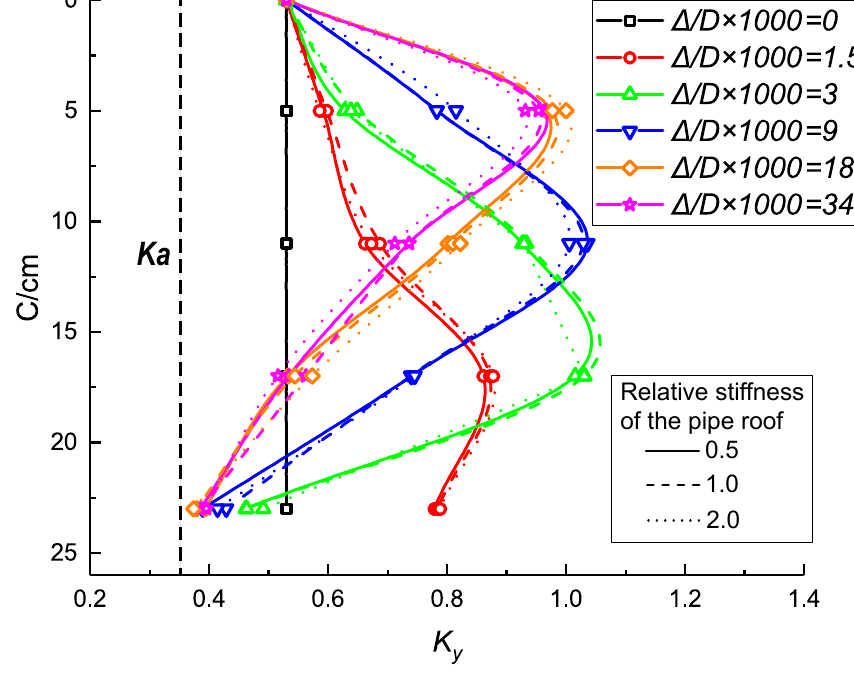
Figure 19. Variation in the longitudinal lateral pressure coefficient (with the pipe